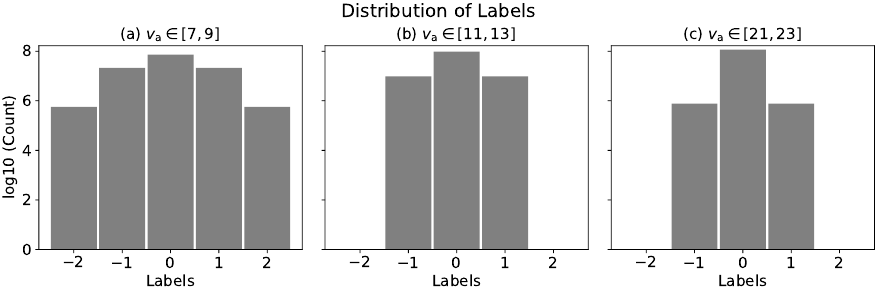
Figure 1. This figure is the distribution of labels with different v a in logarithmic scale: Panel ( a ) represents the distribution of labels on v a ∈ [ 7,9 ] ; panel ( b ) shows on v a ∈ [ 11,13 ] ; and panel ( c ) shows on v a ∈ [ 21,23 ] . When the v a used is higher (left panel to the right panel), the distribution is more skewed to the L 0 .